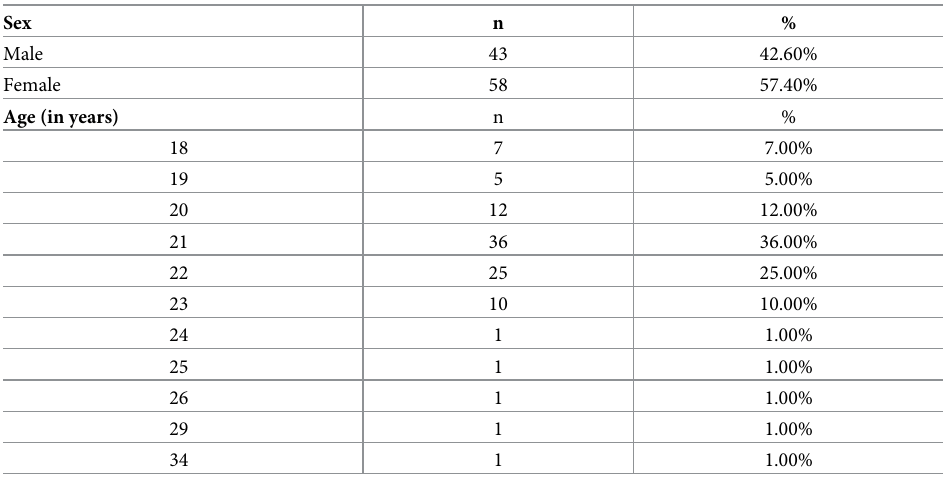
Table 2. Demographic data (n = 101) (Study